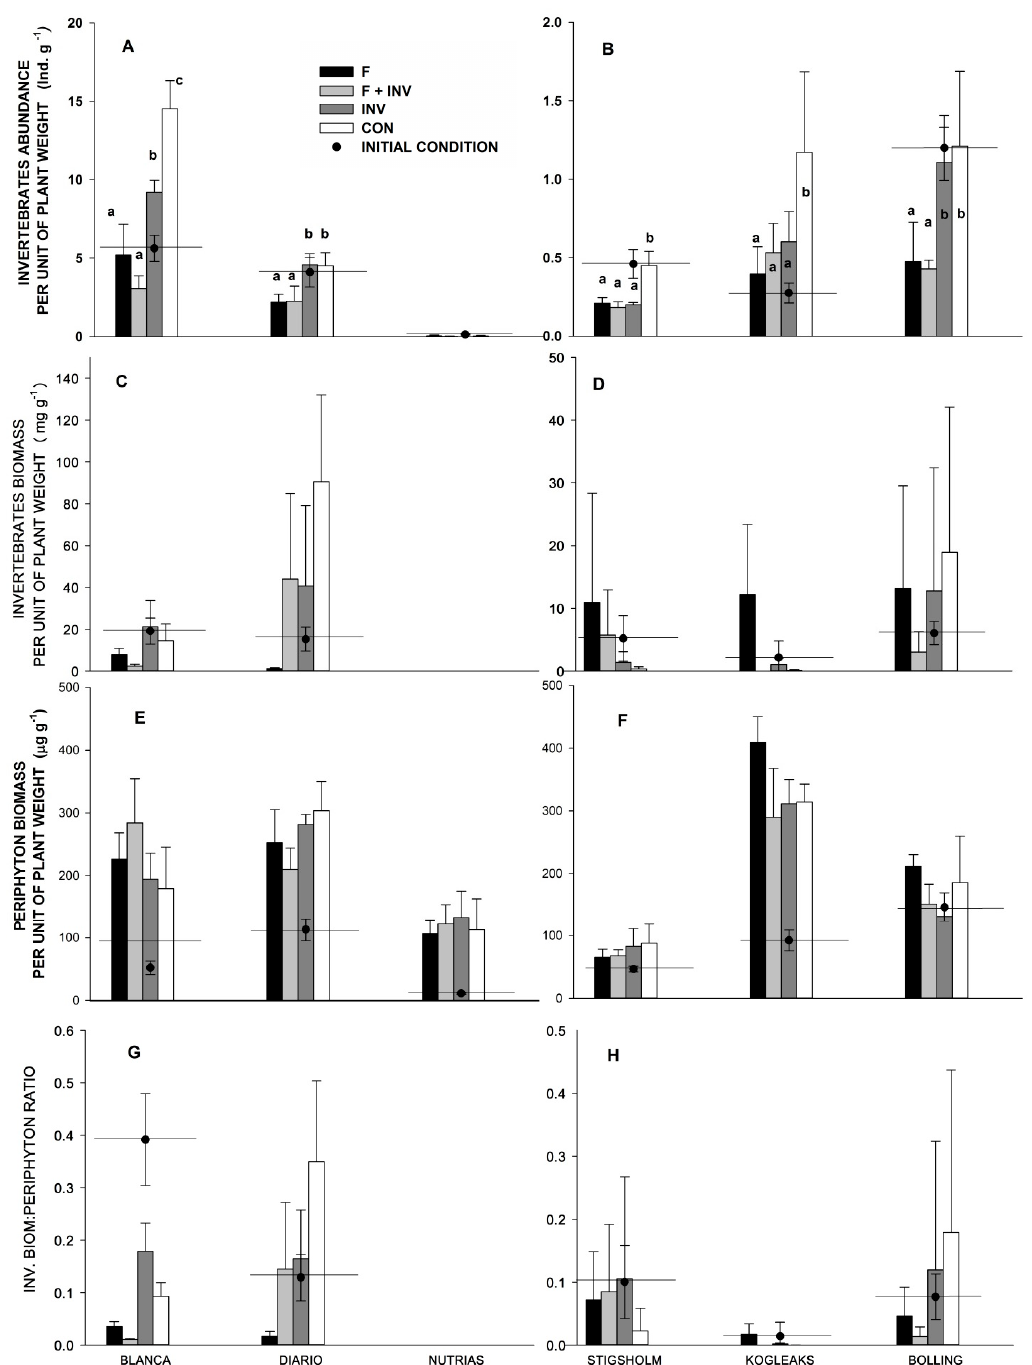
Figure 4. Density ( A , B ) and biomass ( C , D ) of plant-associated macroinvertebrates, periphyton biomass ( E , F ) and potential macroinvertebrates grazing pressure ( G , H ) in subtropical ( left ) and temperate ( right ) lakes. Dotted and horizontal lines represent initial values (15 days after fish exclusion and just before treatment assignment), while columns represent final conditions (49 days after treatment additions). F (fish); F + INV (fish + predatory macroinvertebrates) and INV (predatory macroinvertebrates). Error bars represent ±1 standard error. Please note the different scales on the y -axes. Letters indicate groups according to Tukey’s post hoc tests when ANOVA tests were significant.